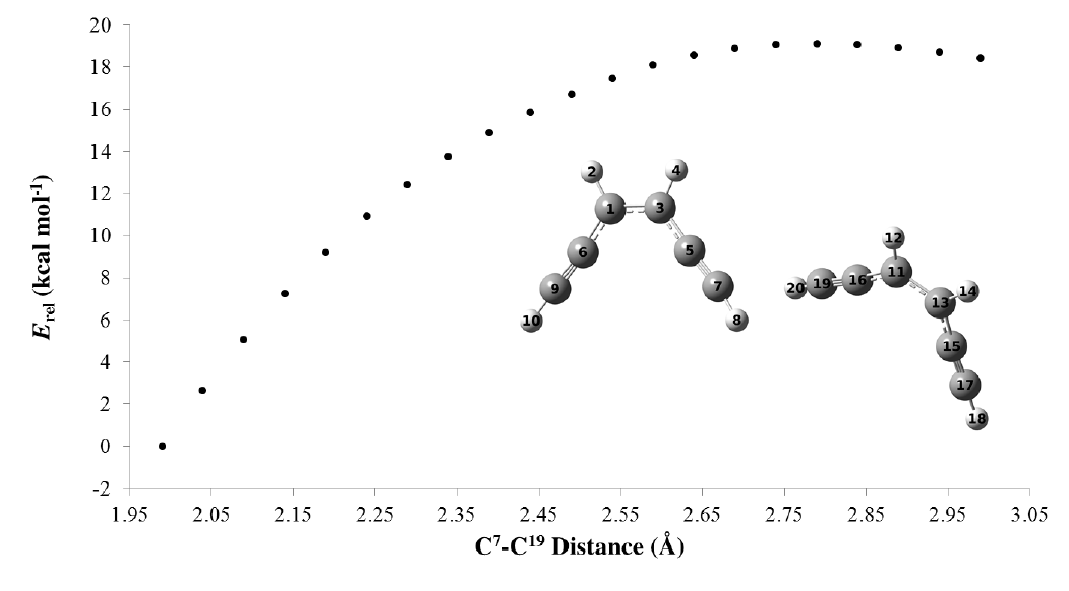
Figure 7. Analysis of the bond formation between C 7 and C 19 by performing the relaxed scan method at (UBS)-BLYP/6-31+G(d) level on the intermolecular reaction between two cation radicals 9 +• (Relative energies are in kcal·mol − 1 and distances are given in